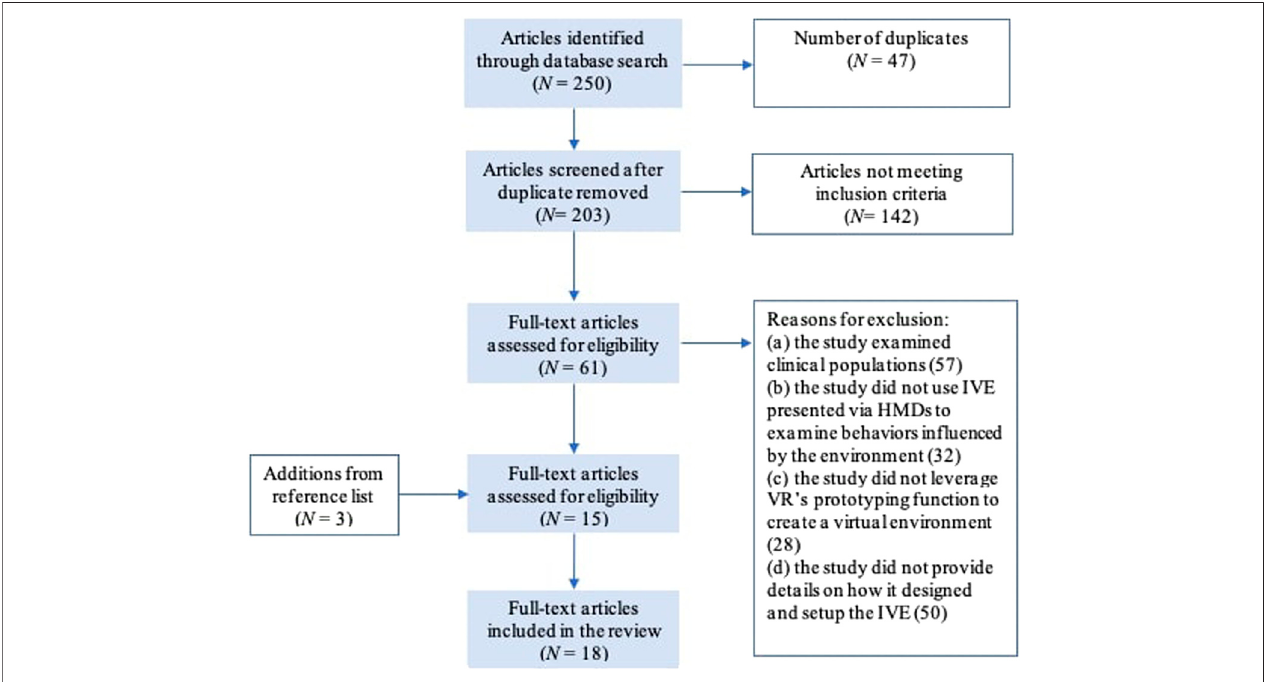
FIGURE 2 | Flow diagram.